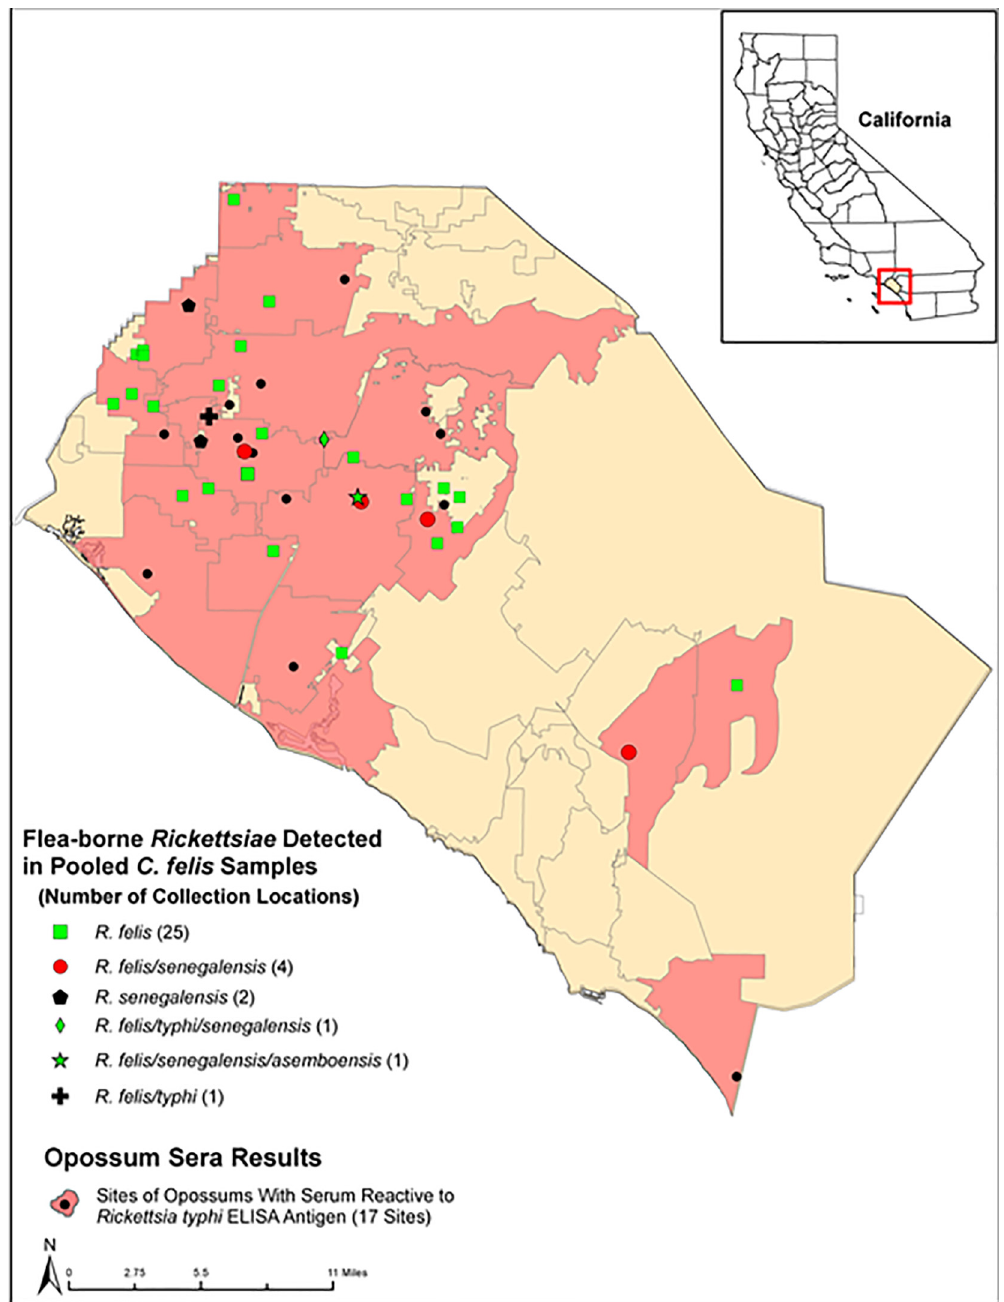
Fig 1. Map showing locations where flea-borne rickettsiae were detected and sites where opossum sera were positive for TGR IgG antibodies in Orange County, California, in 2011 – 2013. relationships inferred from comparison of a 4,292-bp sequence for ompB with other Rickettsia species in GenBank indicates that Ca . R. senegalensis (KF666470) 4,284/4,292 (99.81%) is the closest phylogenetic neighbor to the Orange County molecular isolate (OCFlea 13 0036D) (Fig 2); the closest validated Rickettsia species is R . felis (94.78% match to R . felis URRWXCal2). A 1431-bp fragment of the ompB sequence from the three flea DNA samples was 100% identical